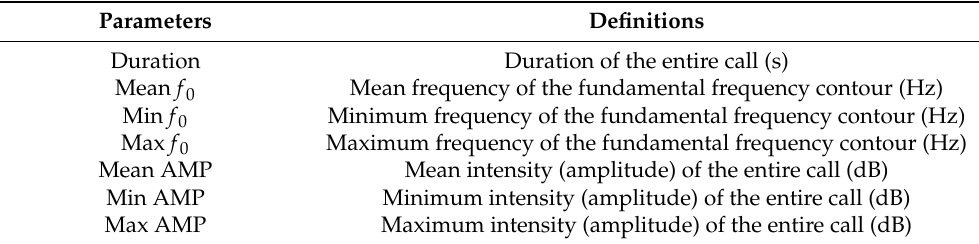
Table 3. Definitions of acoustic parameters in